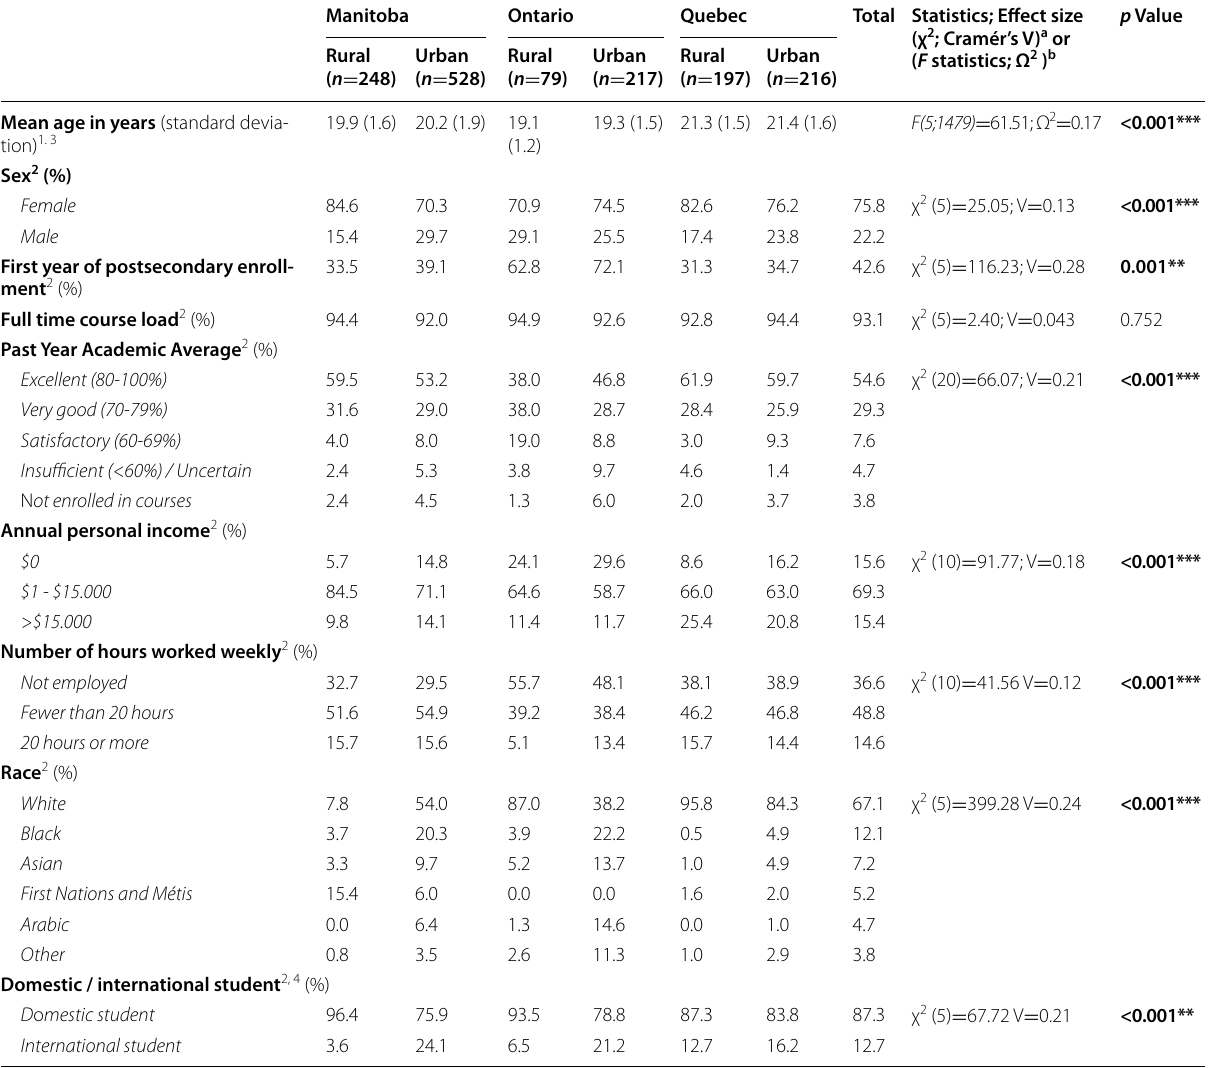
Table 1 Participant Sociodemographic profile by province and rural/urban setting